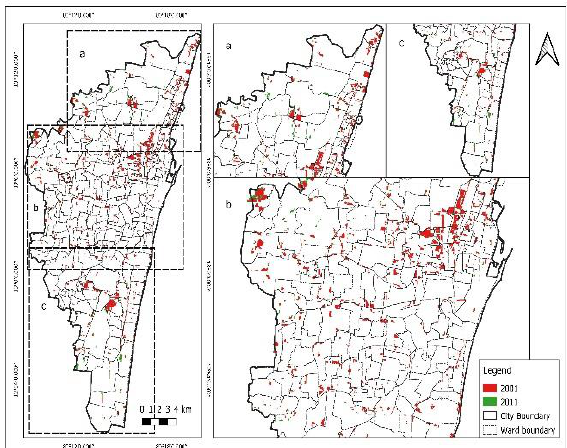
Figure 3. Spatial and temporal analysis of slums Figure 3 above shows the spatiotemporal variation of